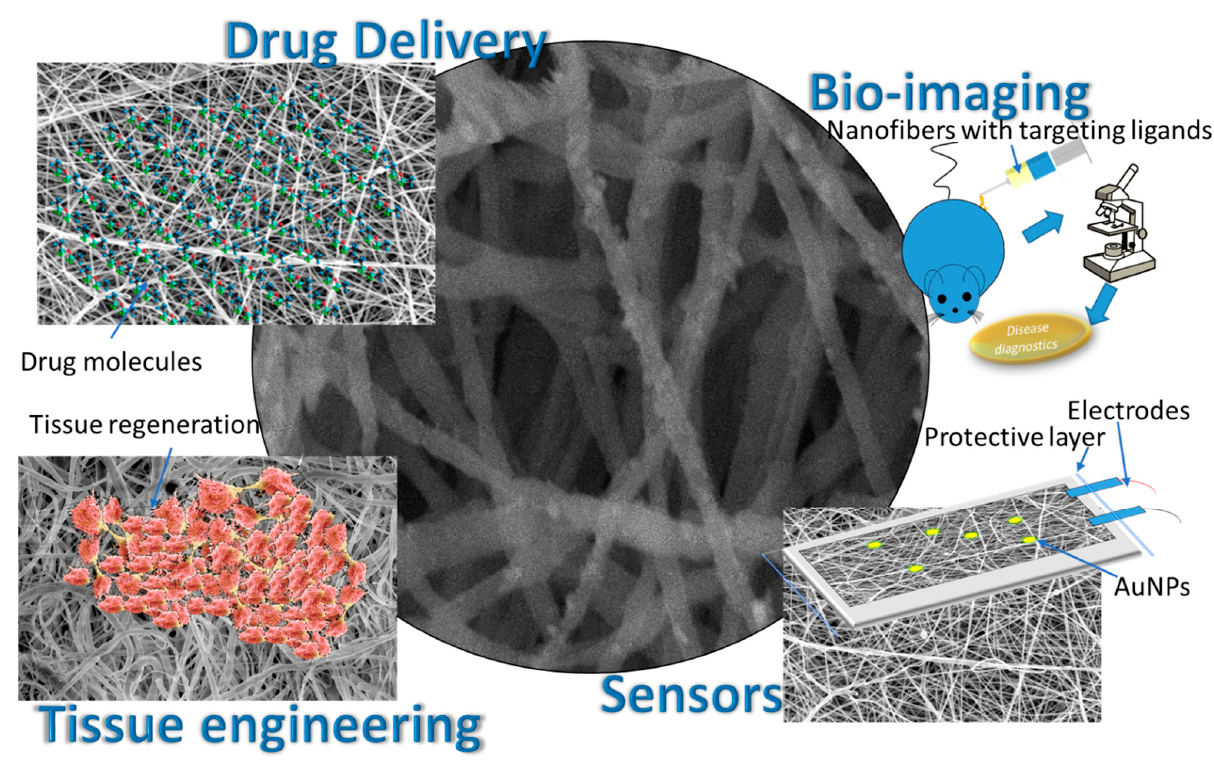
Figure 3. Common biomedical applications of functionalized nanofibers.